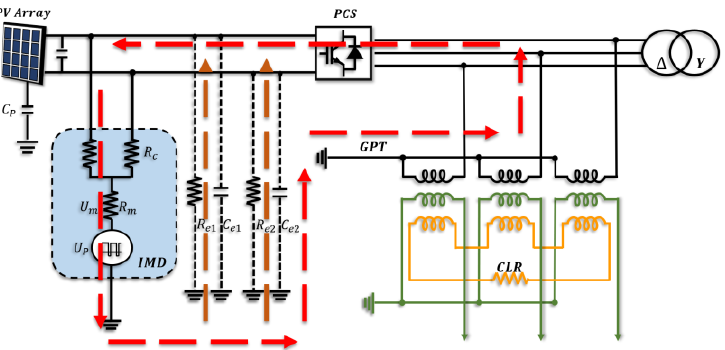
Figure 6. Leakage current loop in ungrounded system connected to transformerless PV generation facilities with IMD and GPT.